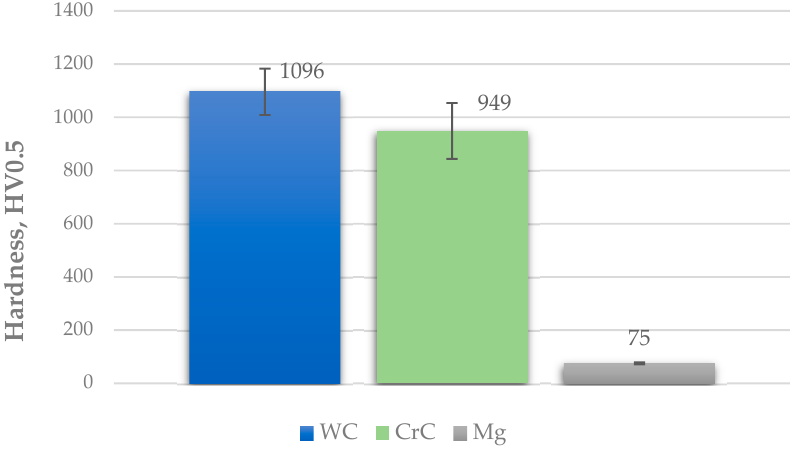
Figure 7. Comparison of average hardness values of the coated samples and substrate.